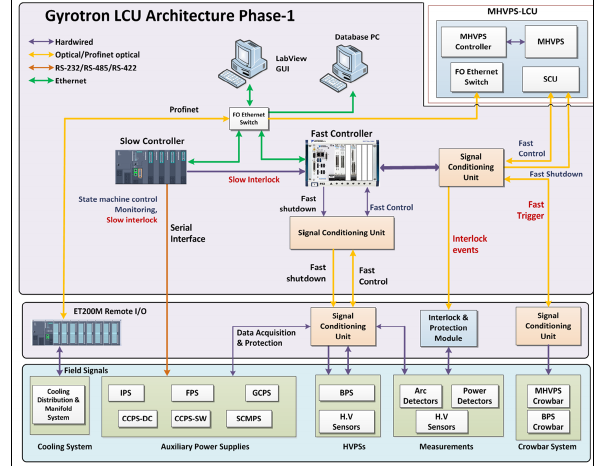
Fig. 9: LCU Architecture (Phase-1)